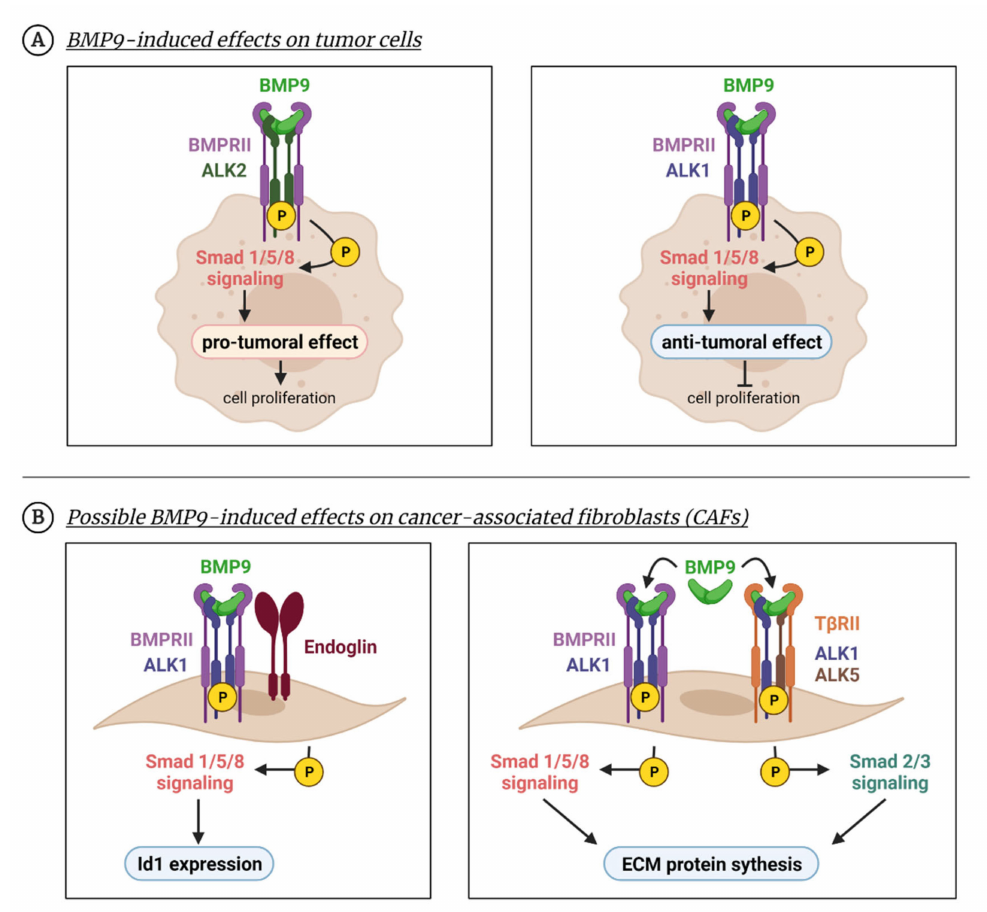
Figure 4. BMP9 effects beyond the endothelium. BMP9 can produce cellular effects in non-endothelial cells as numer- ous studies have shown in tumor cells or fibroblasts . ( A ) BMP9 enhances tumor cell survival in several cancer cell types due to the activation of the Smad1/5/8 pathway through ALK2 receptor ( left panel ). Apart from Smad1/5/8, other non-canonical pathways such as p38 are activated. In different tumoral cell lines, BMP9 induces an anti-proliferative effect by activating the Smad1/5 pathway through the ALK1 receptor ( right panel ). ( B ) BMP9 can induce responses in fibroblast-like cells, such as CAFs, in which BMP9 promotes Id1 expression through the ALK1-Smad1/5/8 pathway ( left panel ). In MEFs, BMP9 induces a profibrotic program through both Smad1/5/8 and Smad2/3 pathways ( right panel ). Created with BioRender.com, accessed on 17 October